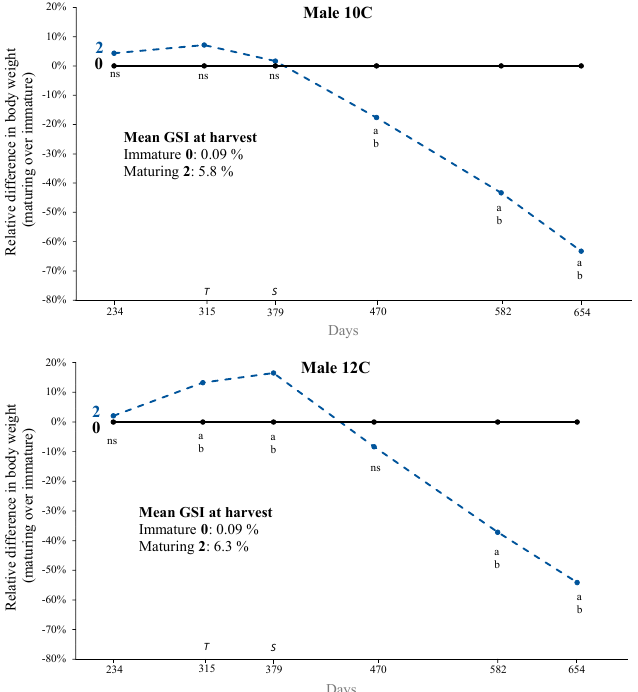
Figure 4. Body weight (W) progression of immature male Arctic charr in experimental groups 10C and 12C, relative to maturing conspecifics. The maturity stages are based on gonadosomatic indices (GSI) at harvest on day 654. Immature males in stage 0 had GSI from 0.01% to 0.2%, while those in stage 2 had GSI > 2%. Males in maturity stage 1 are excluded from this analysis due to low numbers of individuals. On day 315 all groups were acclimatized to 7 °C ( T ) and reared at 7–8 °C until har- vest. On day 379 all groups were subjected to an abrupt increase in salinity from 4 to 22 ppt ( S ). Different lower-case letters denote significant differences between groups at the 5% level of signif- icance. As for the males, the maturing females in the 10C and 12C groups were generally somewhat larger than the immature females during the juvenile stage, but over the course of the experiment there was a progressive decline in the relative size difference between immature and maturing females, until the immature females transcended the maturing females and became significantly larger than females in maturation stages 2 and 1 on days 582 and 654, respectively (Figure 5).